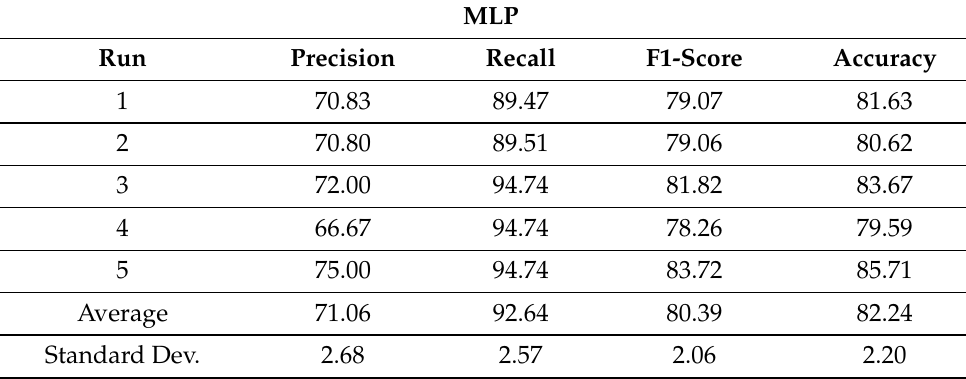
Table 6. Summary of the results obtained with the MLP model. We collect the obtained test set metrics computed over five different runs. The last two rows report the average over the runs and the corresponding standard